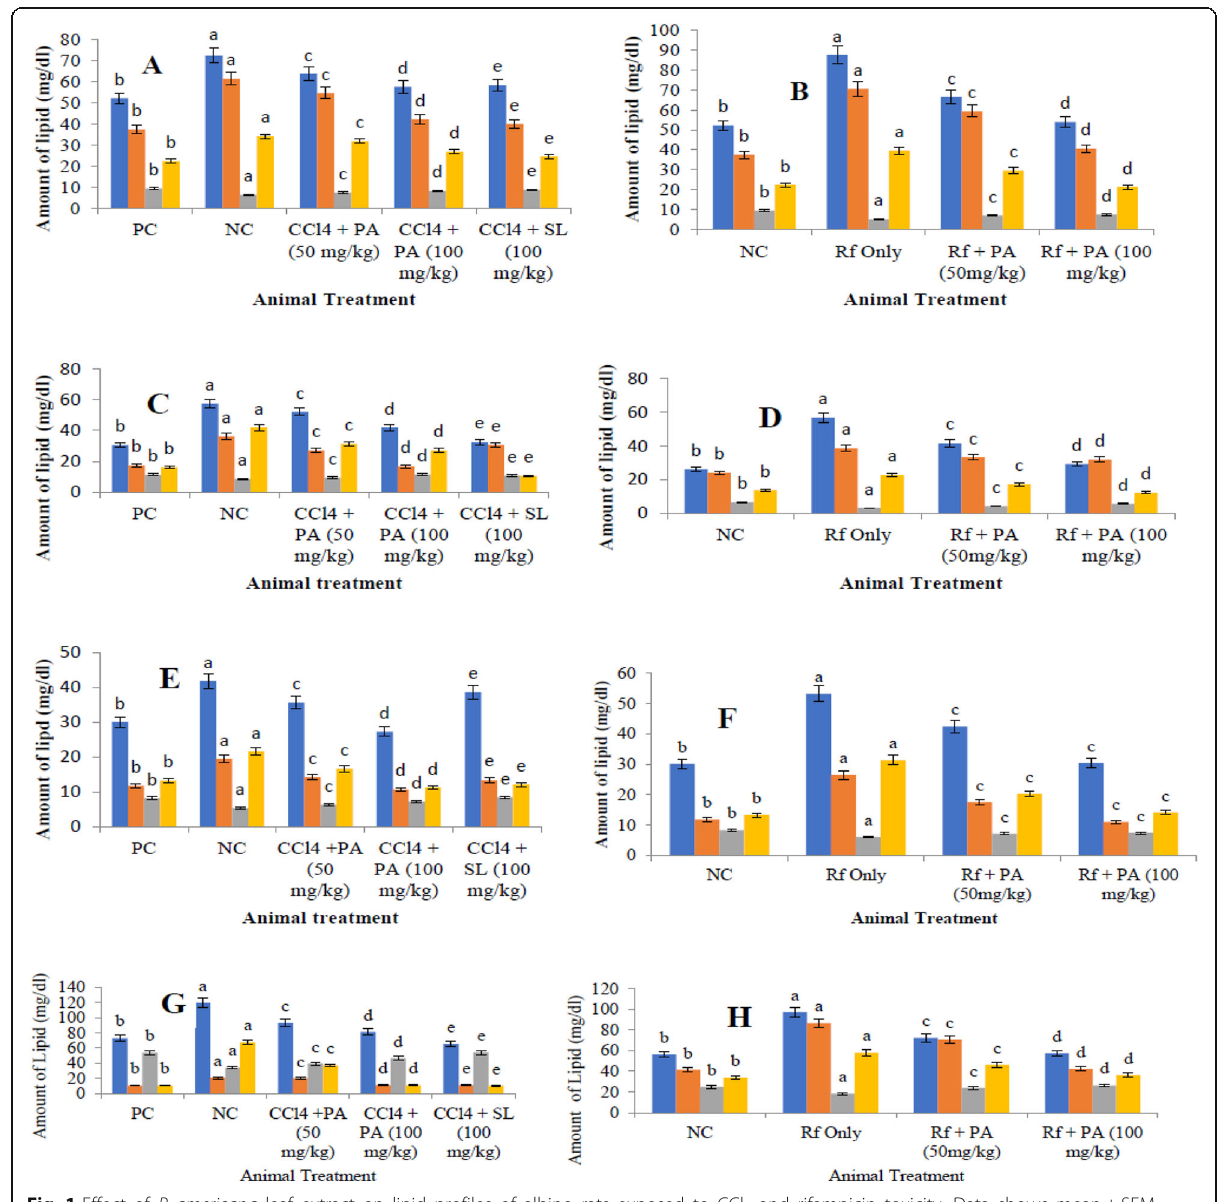
Fig. 1 Effect of P americana leaf extract on lipid profiles of albino rats exposed to CCl 4 and rifampicin toxicity. Data shows mean ± SEM values of four independent experiments performed in triplicate. ‘ b ’ , ‘ c ’ , ‘ d ’ and ‘ e ’ represent significant difference ( p <0.05) from ( ‘ a ’ ) – the positive control (NC); PC- negative control; PA- Pearse americana ; SL- Silymarin. Rf- Rifampicin. HDL- CHOL- TRIG- LDL- a and b are liver of CCl 4 and rifampicin- challenged rats respectively. c and d are heart of CCl 4 and rifampicin- challenged rats respectively; e and f are kidney of CCl 4 and rifampicin- challenged rats respectively; g and h are serum of CCl 4 and rifampicin challenged rats